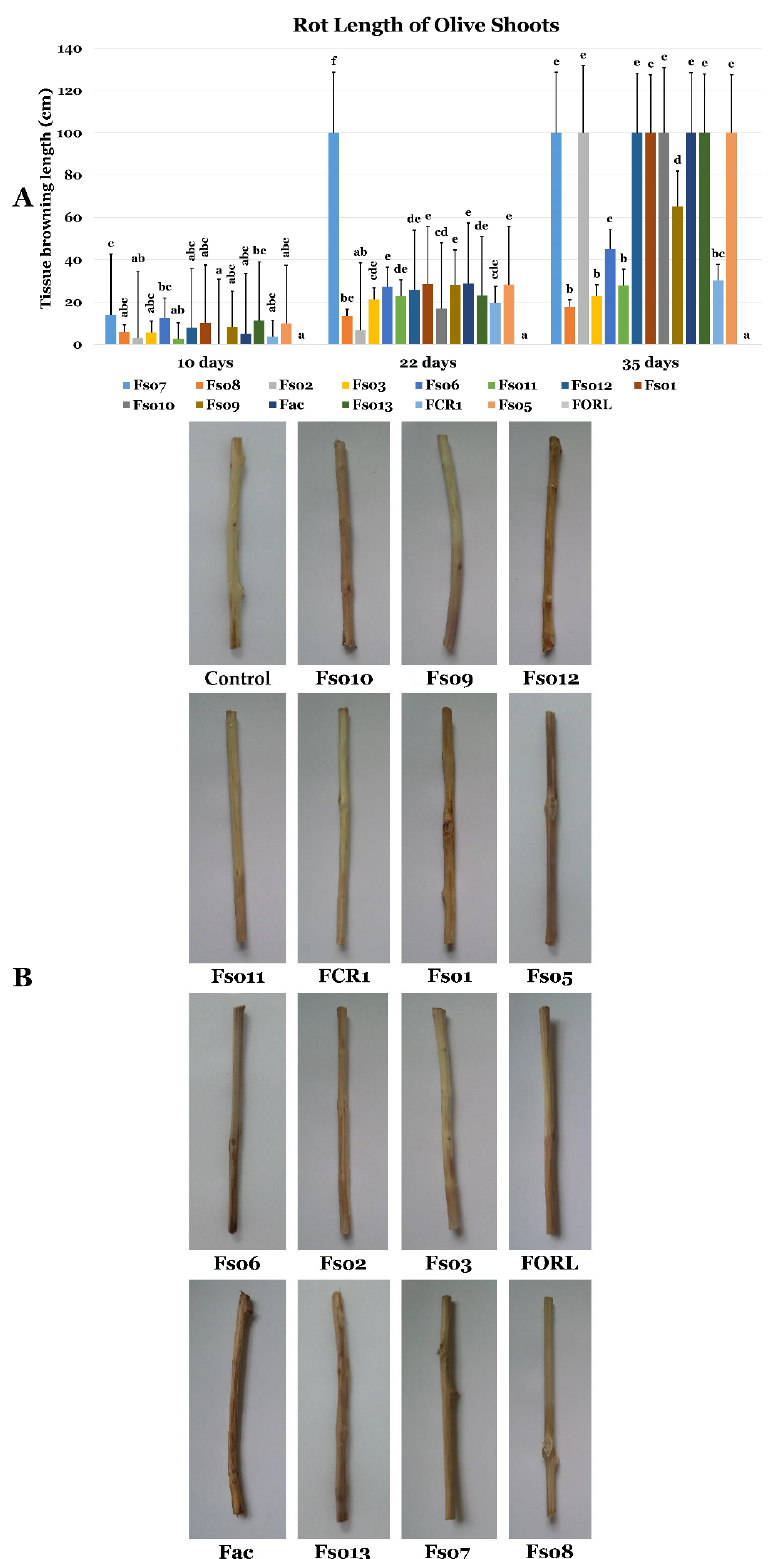
Figure 12. ( A , B ) Rot length of olive tree shoots (mm) caused by Fusarium spp. strains at 10, 22 and 35-days post-inoculation. Data presents mean ± standard error. Bars labelled with di ff erent letters are significantly di ff erent among the treatments at p < 0.05 using Tukey’s HSD